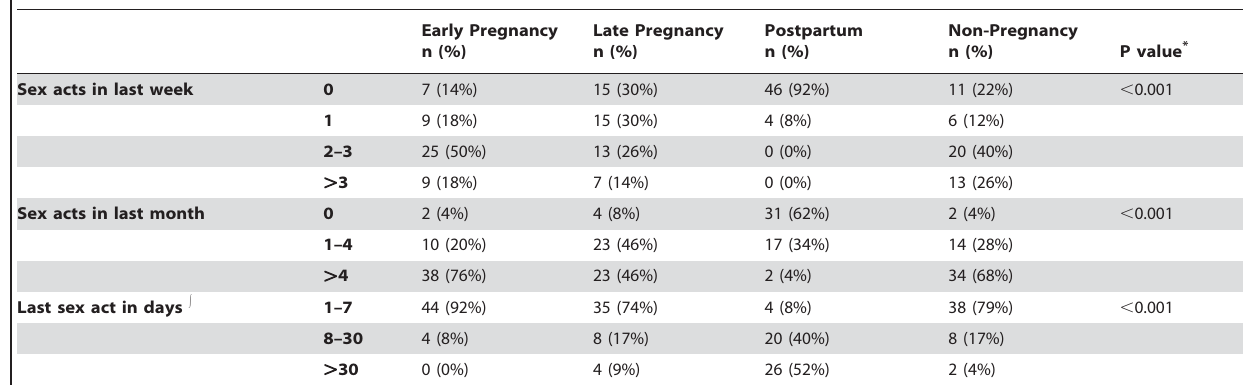
Table 2. Sexual behavior by study